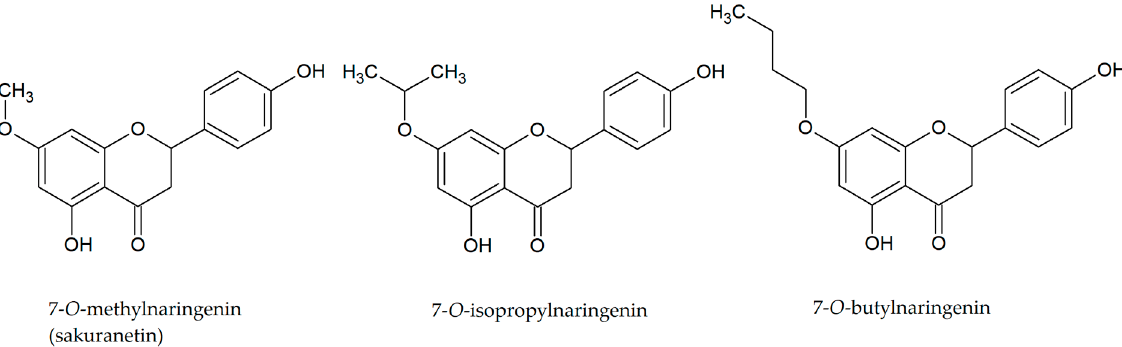
Figure 2. Structures of O -alkyl derivatives of naringenin.